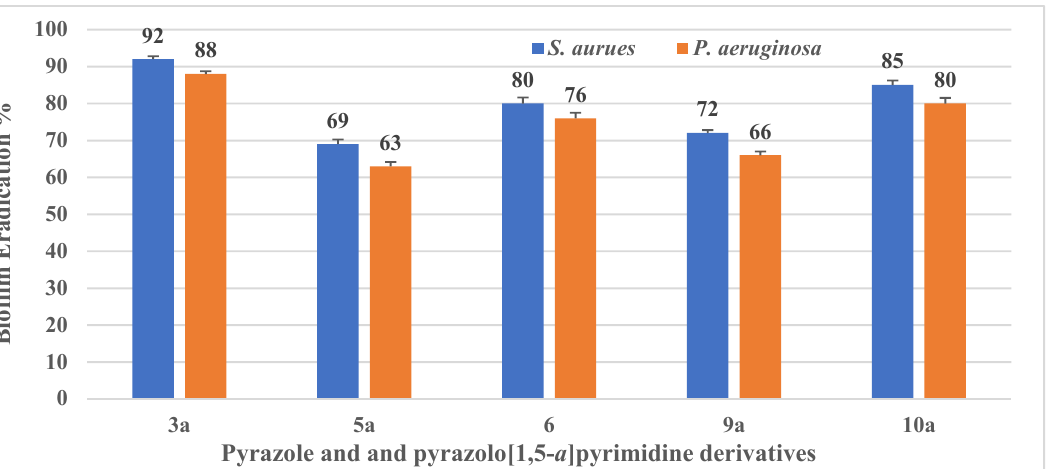
Figure 2. Antibiofilm activity of pyrazoles 3a and 5a and pyrazolo[1,5- a ]pyrimidine derivatives 6 , 9a , and 10a at their MICs against S. aureus and P. aeruginosa bacterial isolates. The biofilm was quantified using the crystal violet staining assay at OD 570 .